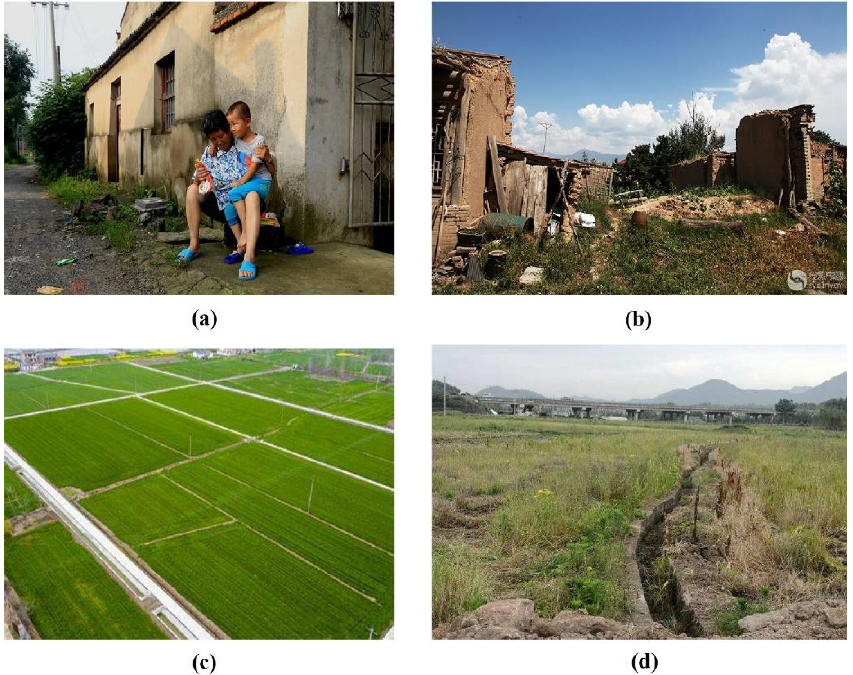
Figure 1. Problems caused by the loss of rural population: ( a ) Left-behind elderly and children. ( b ) Abandoned homesteads. ( c ) Small patch arable land. ( d ) Abandoned arable land.